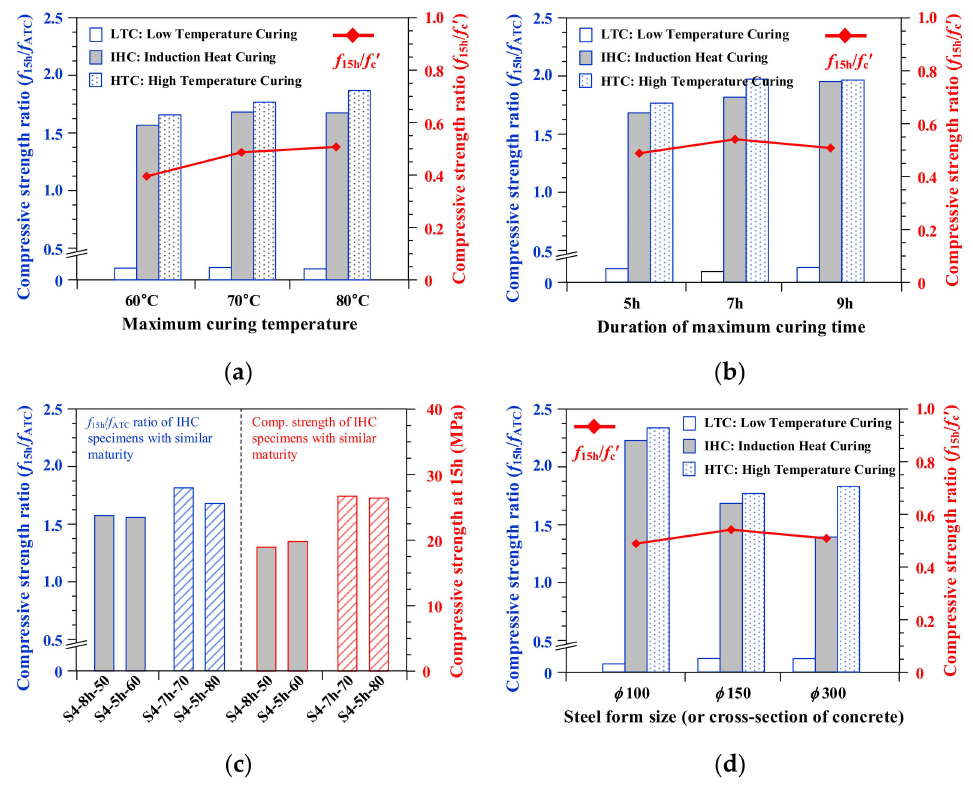
Figure 11. Comparisons of compressive strength ratios: ( a ) effects of maximum curing temperature; ( b ) effects of duration of maximum curing time; ( c ) effects of maturity for IHC specimens; ( d ) effects of cross-sectional